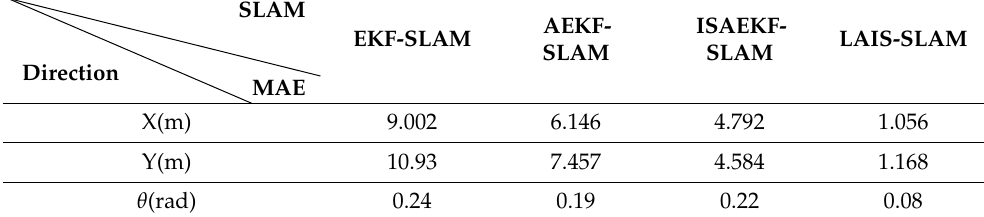
Table 3. The MAE of each algorithm in three directions.